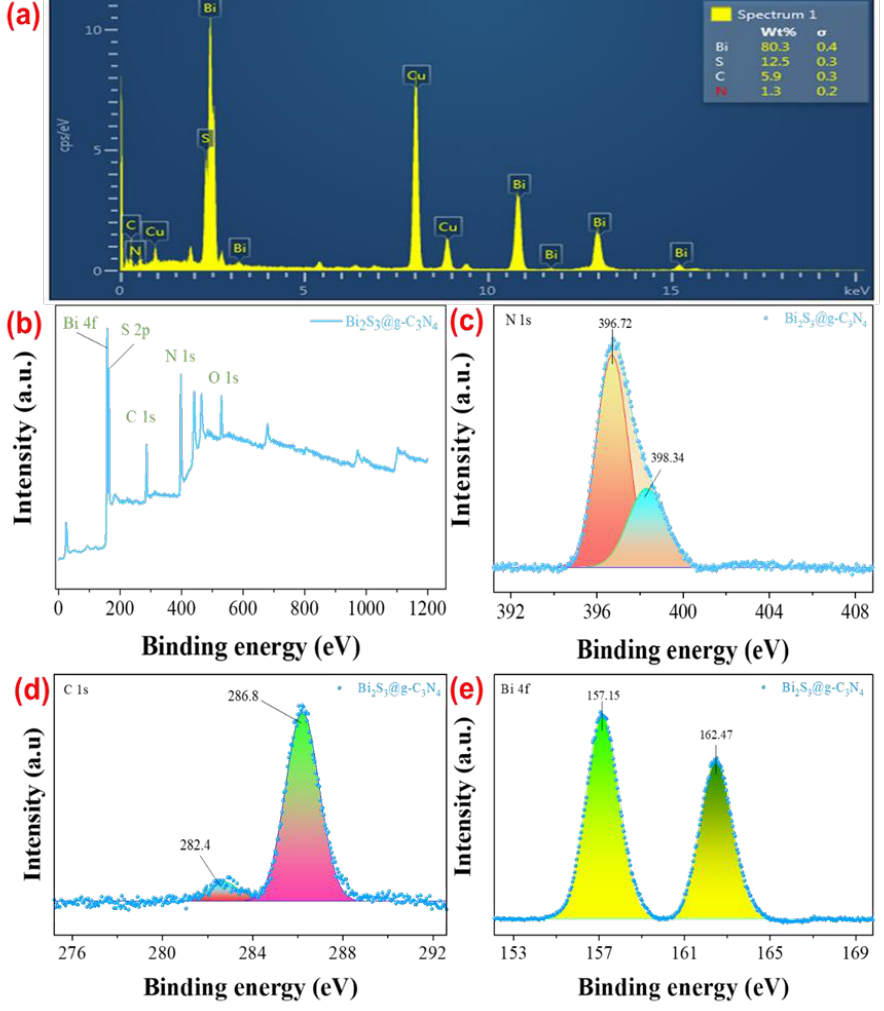
Figure 4. ( a ) The EDX-mapping of the synthesized Bi 2 S 3 @g-C 3 N 4 , ( b ) the XPS Survey, and the XPS high resolution spectra, ( c ) the N 1s spectrum, ( d ) the C 1s spectrum, and ( e ) the Bi 4f spectrum.